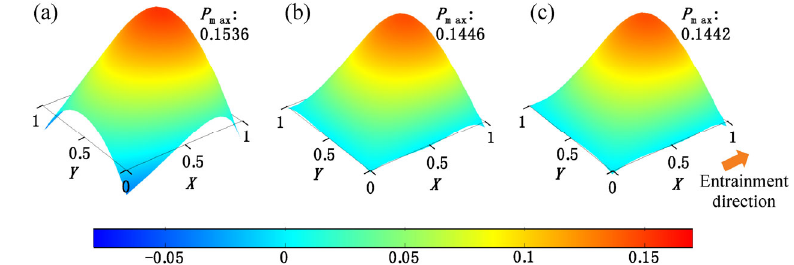
Fig. 9 Pressure distribution with different node numbers per layer. (a) N n = 4, (b) N n = 16, and (c) N n = 32.